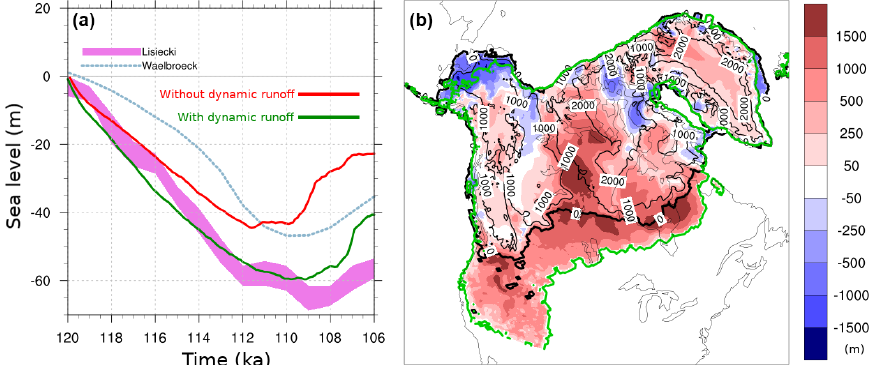
Figure 7. The impact of meltwater runoff inclusion in the coupled model; (a) total ice volume evolution at glacial inception with (green) and without (red) dynamic meltwater routing, and (b) NA ice thickness difference at 110ka with and without dynamic runoff routing. Contours show the ice thickness in the simulation without dynamic runoff routing. Thick black and green contours show the ice margin in the control and dynamic runoff routing run,